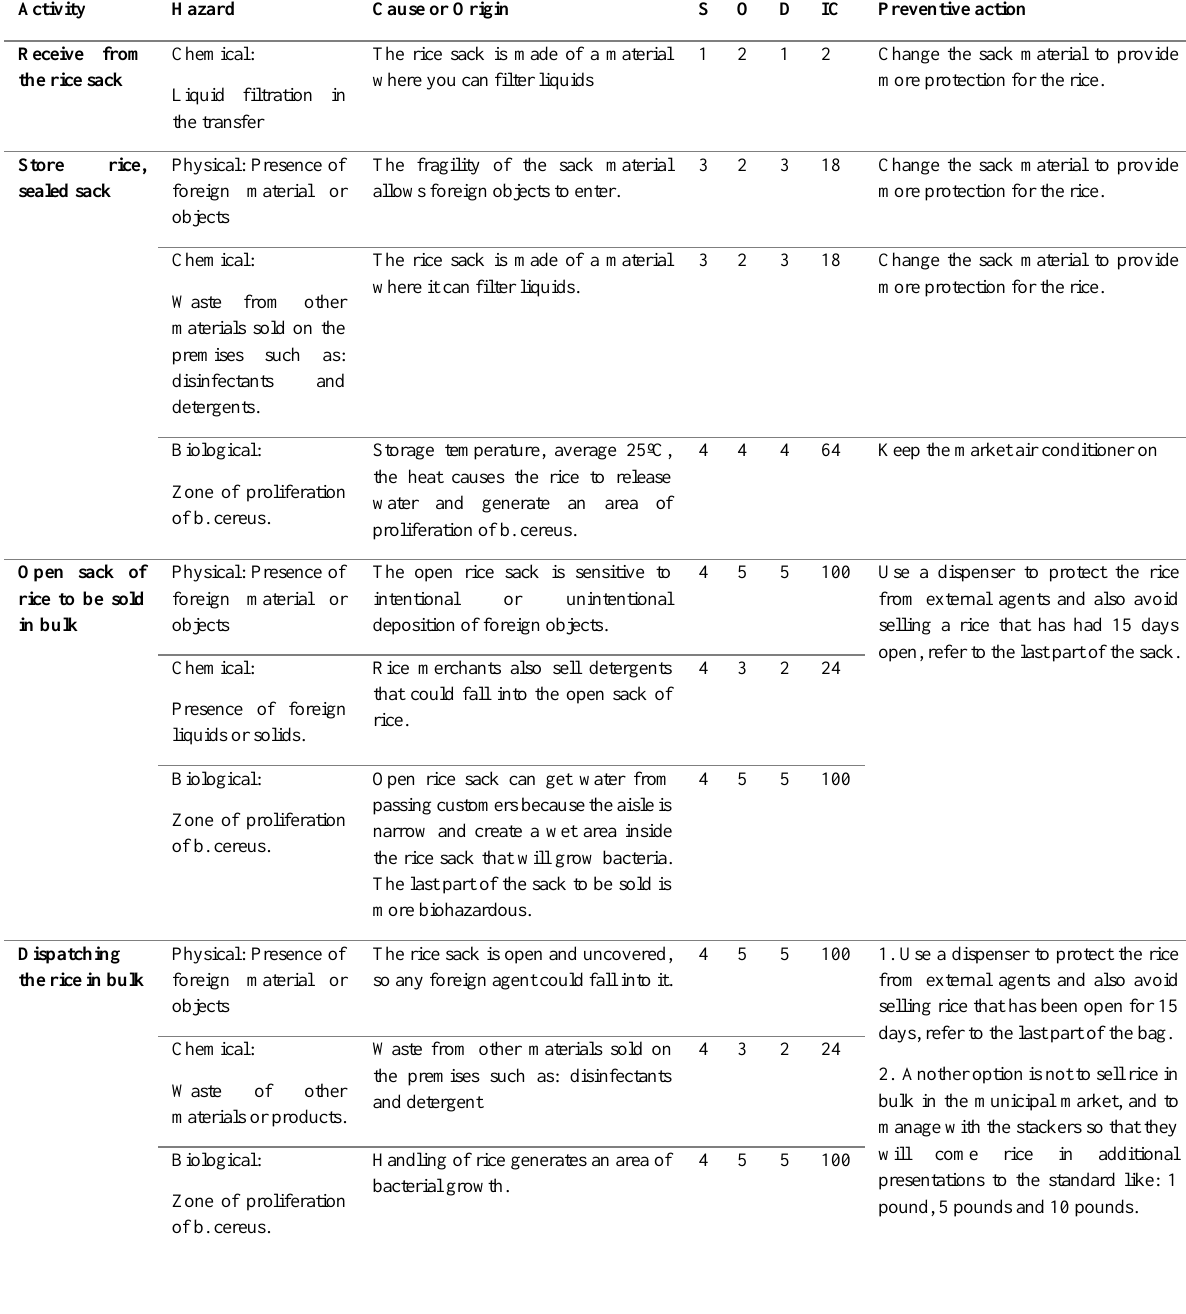
Table 3: Criticality index by